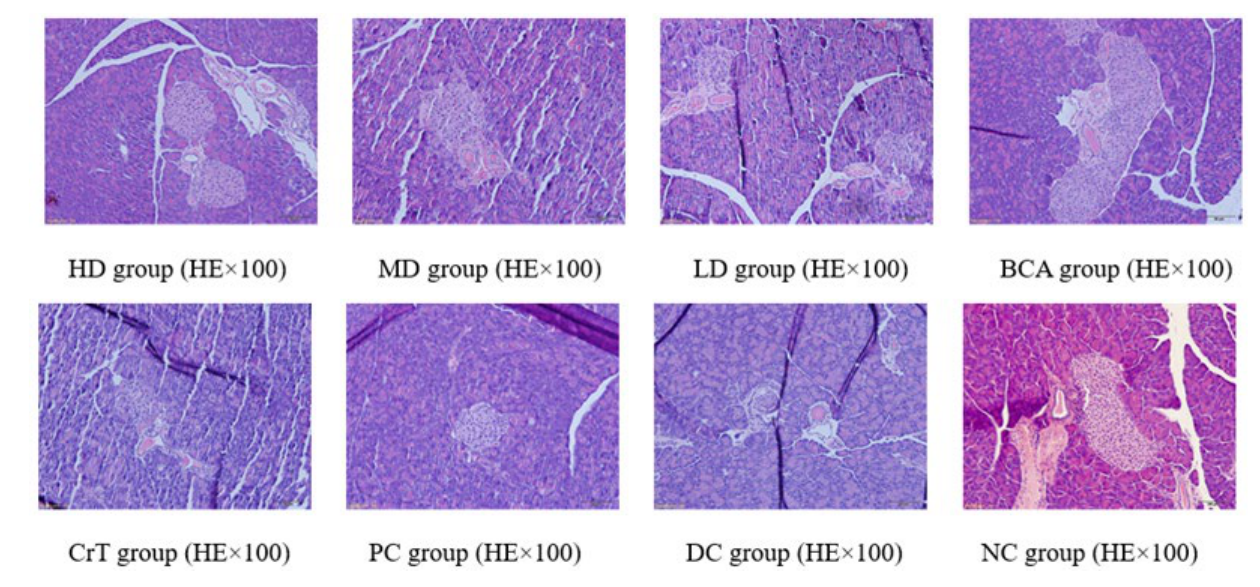
Figure 13. Morphological changes in pancreatic tissue.